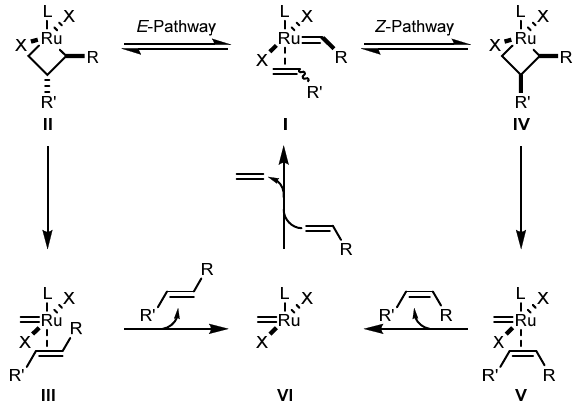
Figure 1. Catalytic cycle for olefin metathesis (OM) illustrating how stereochemical relationships in the ruthenacyclobutane affect the stereochemistry of the formed olefin.